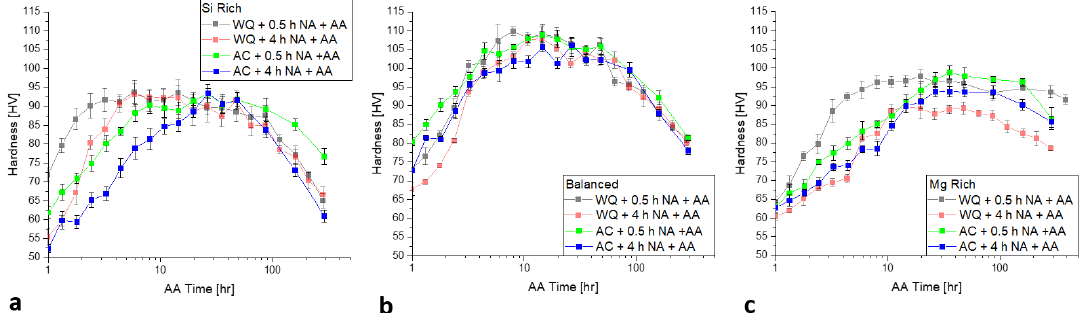
Figure 6. High strength alloy AA hardness evolution after AC and WQ, for both prior NA conditions (labelled accordingly). WQ results are included, and plotted semi-transparently, for comparative purposes. Error bars represent 95% confidence.